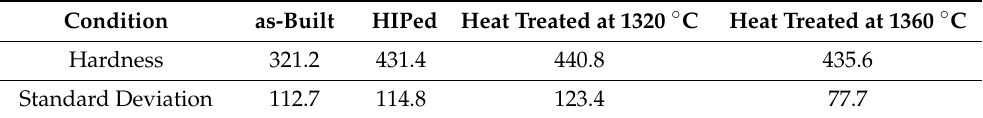
Table 3. Average hardness values (HV 0.1) measured for each sample.